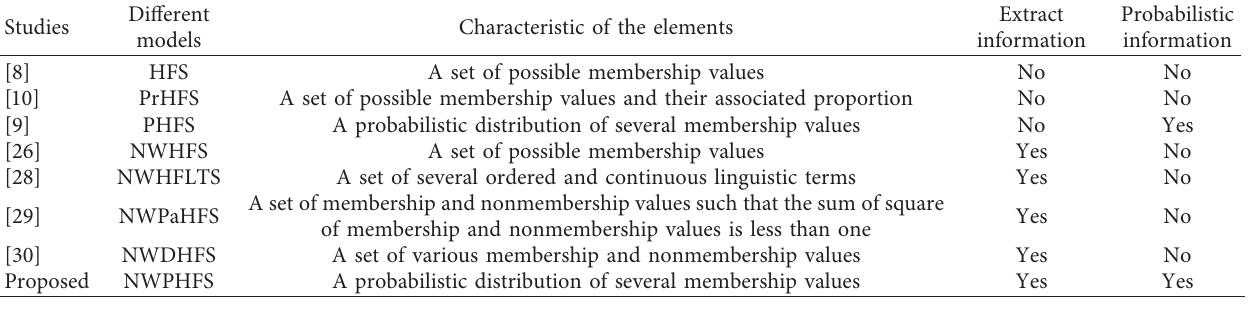
Table 1: A summary on the normal wiggly hesitant fuzzy set and its